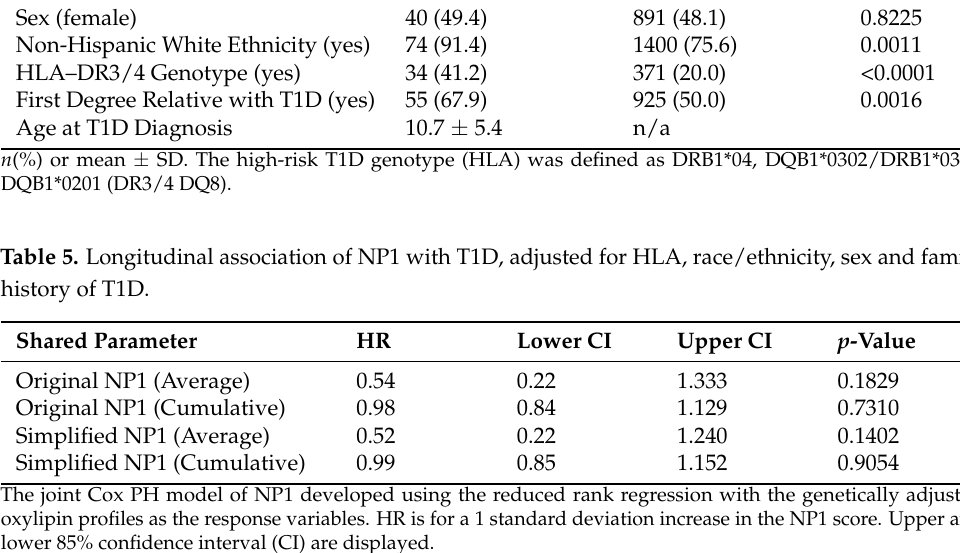
Table 4. DAISY participant characteristics with at least one food frequency questionnaire ( n = 1933). Variable